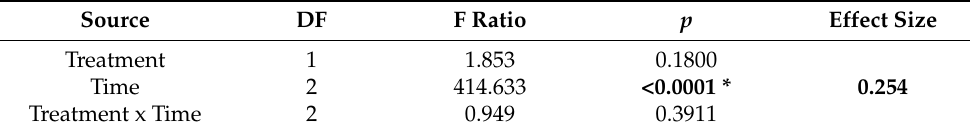
Table 6. Alternative use test results of the mixed-model repeated measures ANOVA.